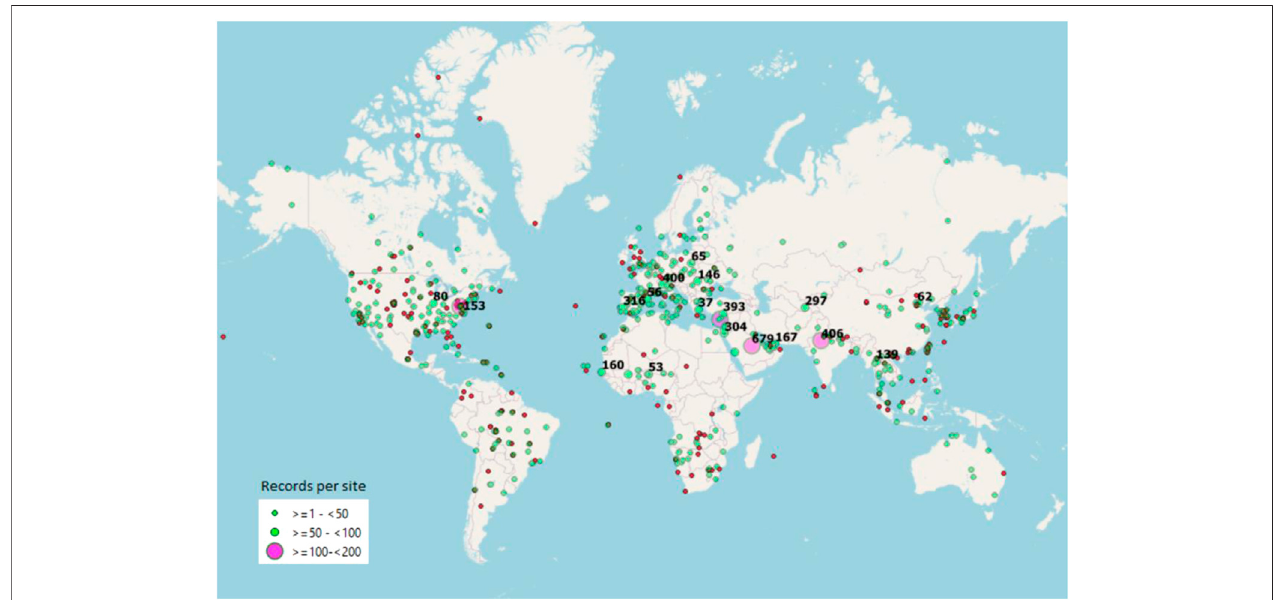
FIGURE 2 | The global network of AERONET sites. The sites with > 50 daily records are labeled with numbers (see Supplementary Appenedix Table A2 for speci fi c site names). The green and magenta circles denote the sites whose observations were utilized in clustering. The sites without SSA/AE a inversions are marked with red circles. The data for developing PAM models were collected between October-1993 and September-2019.